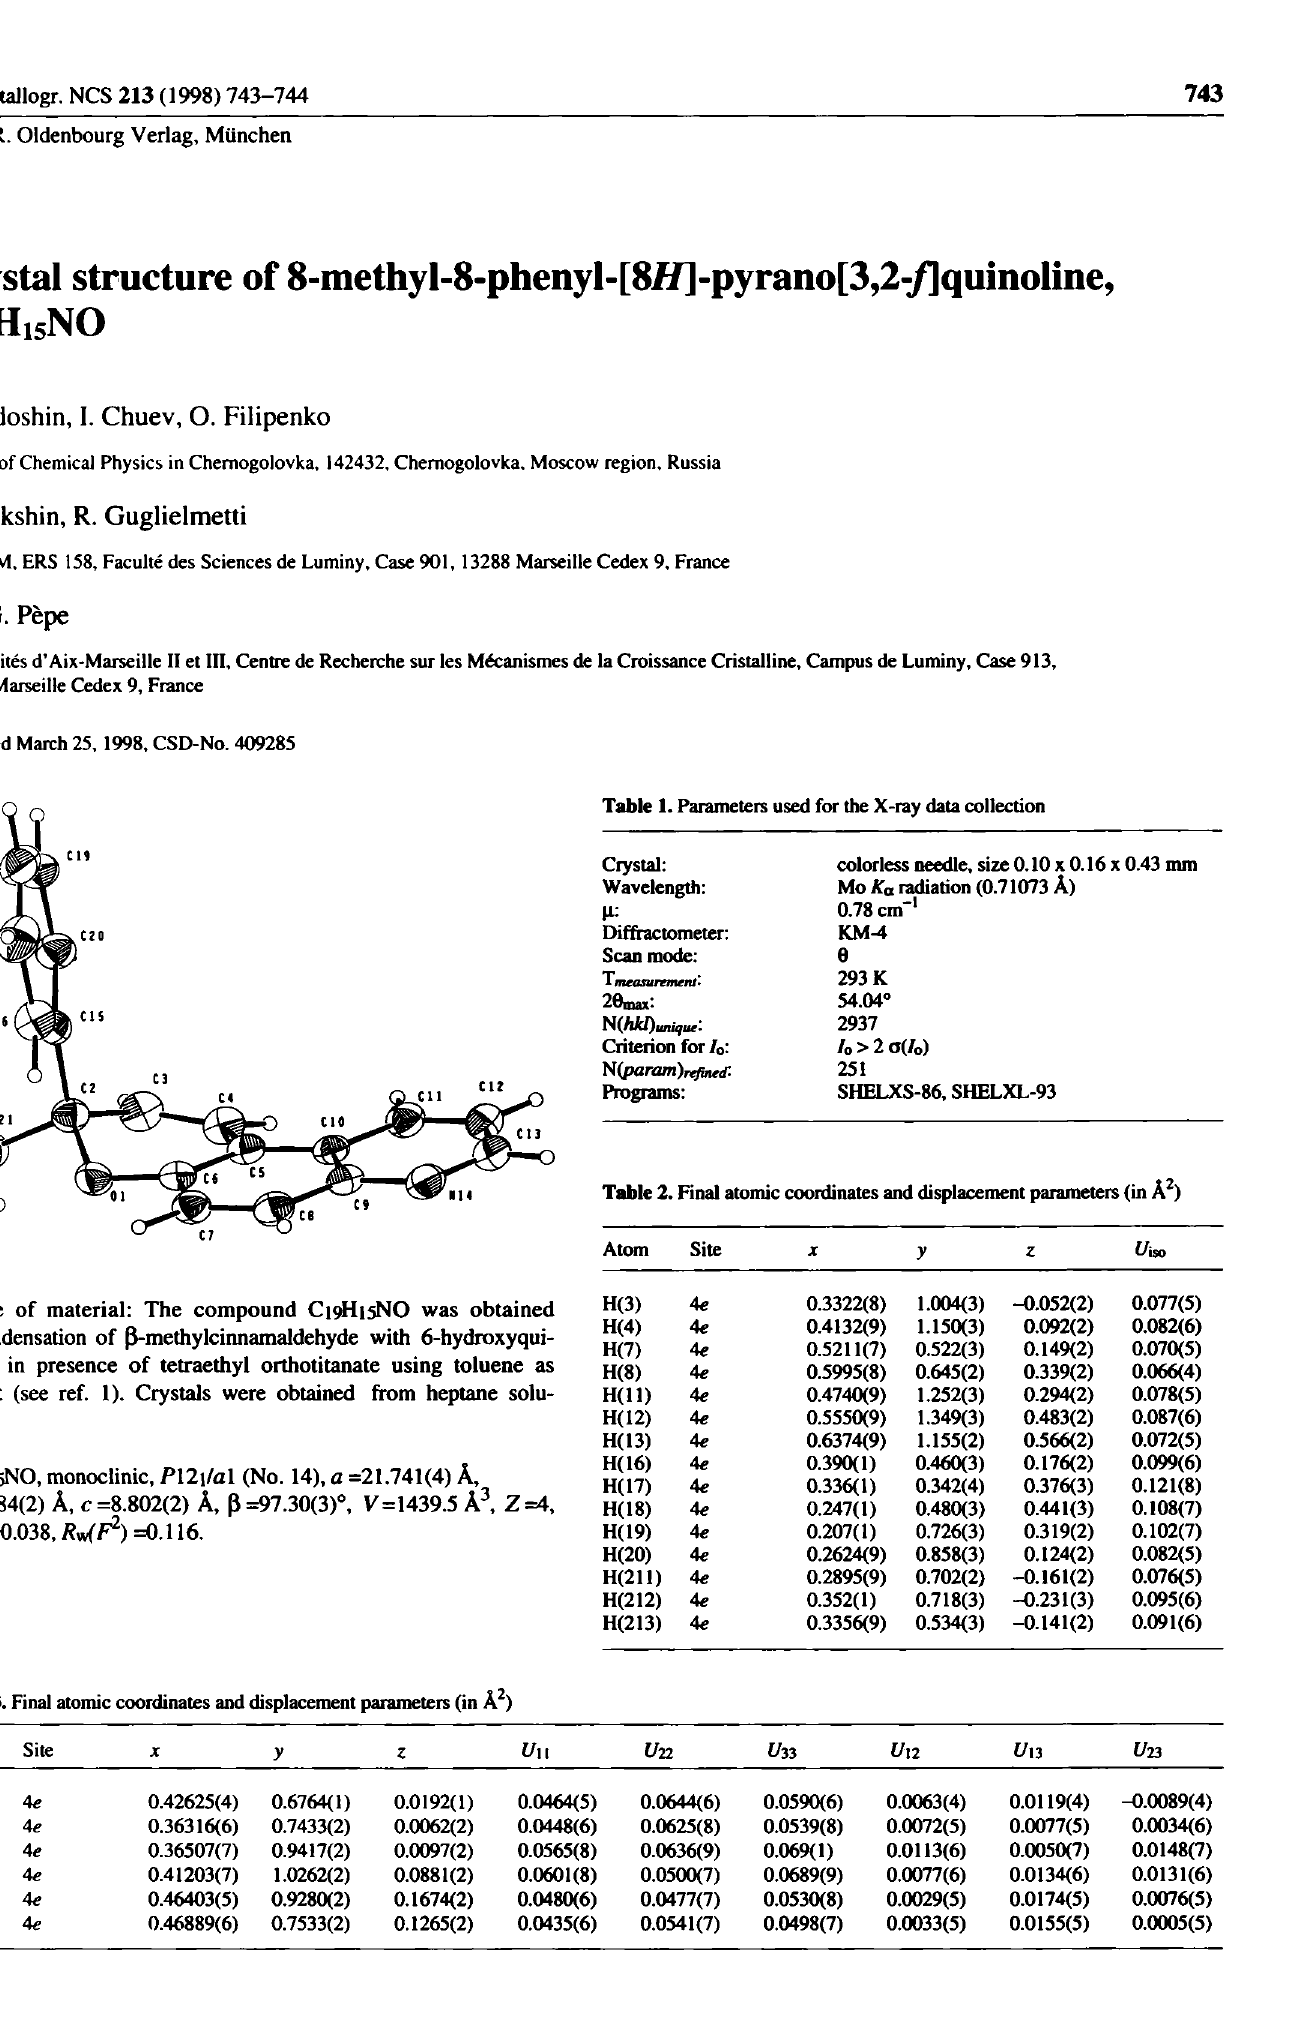
Table 3. Final atomic coordinates and displacement parameters (in A^) Atom